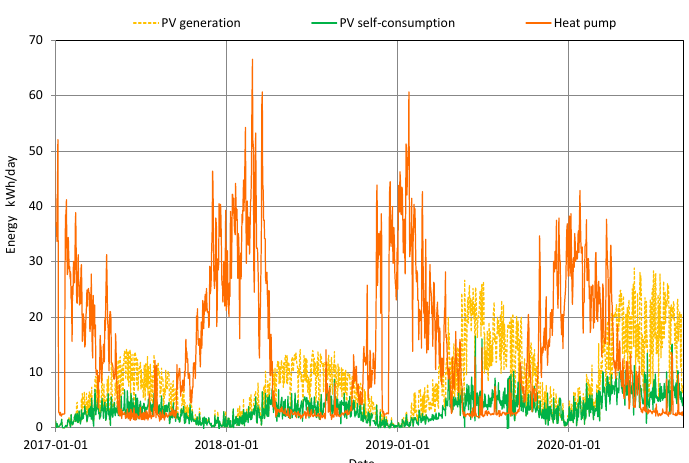
Figure 10. Over three years of data collection of energy PV generation, PV self-consumption and HP